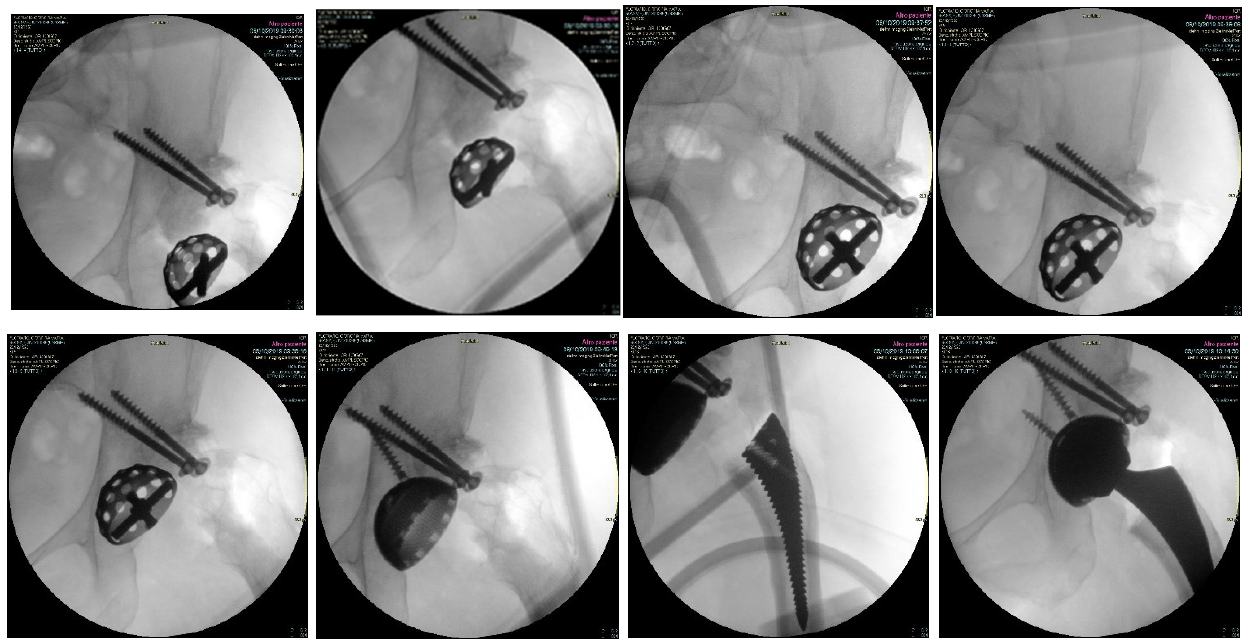
Figure 1. Progressive reaming in the true acetabulum, with the autograft kept in place by two screws, to improve the superior horizontal coverage.